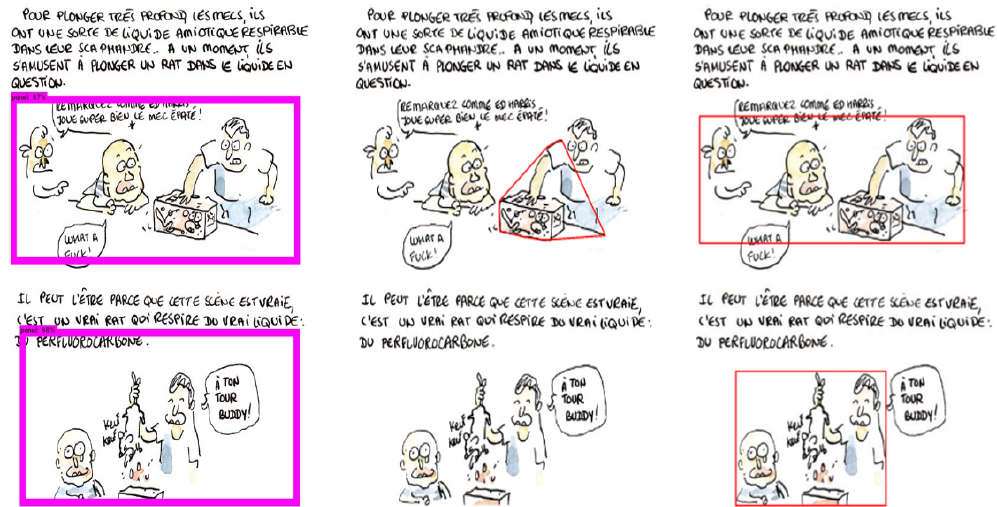
Figure 10. Panel detection on difficult pages (eBDtheque). The first column shows panel detections from the CNN model. The second column is detections from the algorithm in [6]. The last column is for ground-truth regions. Detections are represented by pink or red